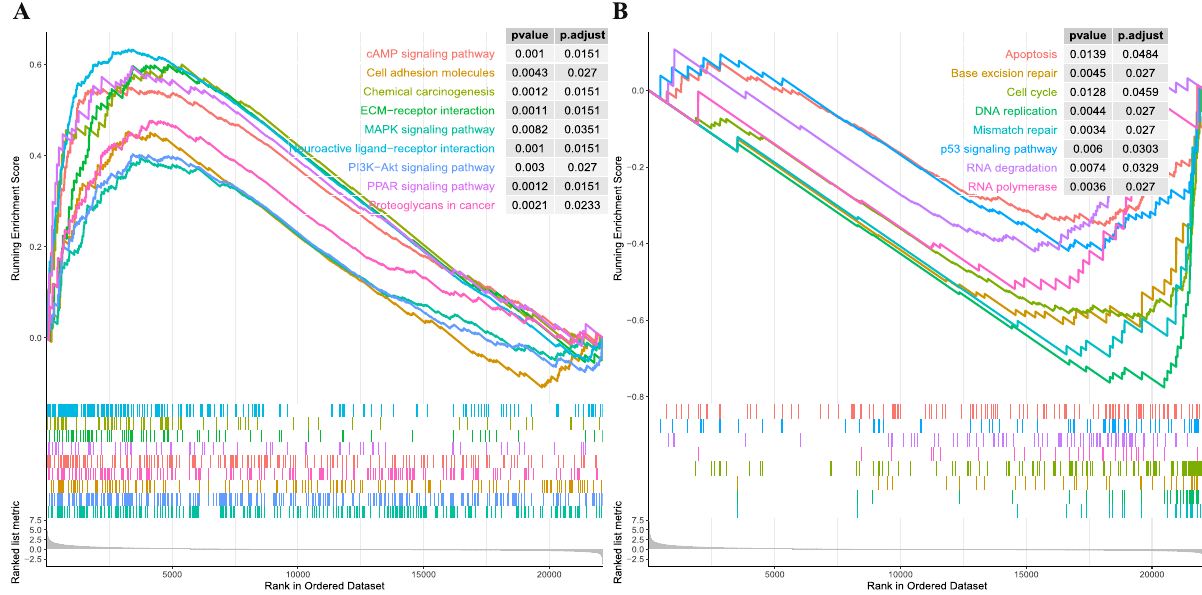
Figure 7. GSEA illustrated the significantly altered biological processes in high-risk group and low-risk group in the TCGA